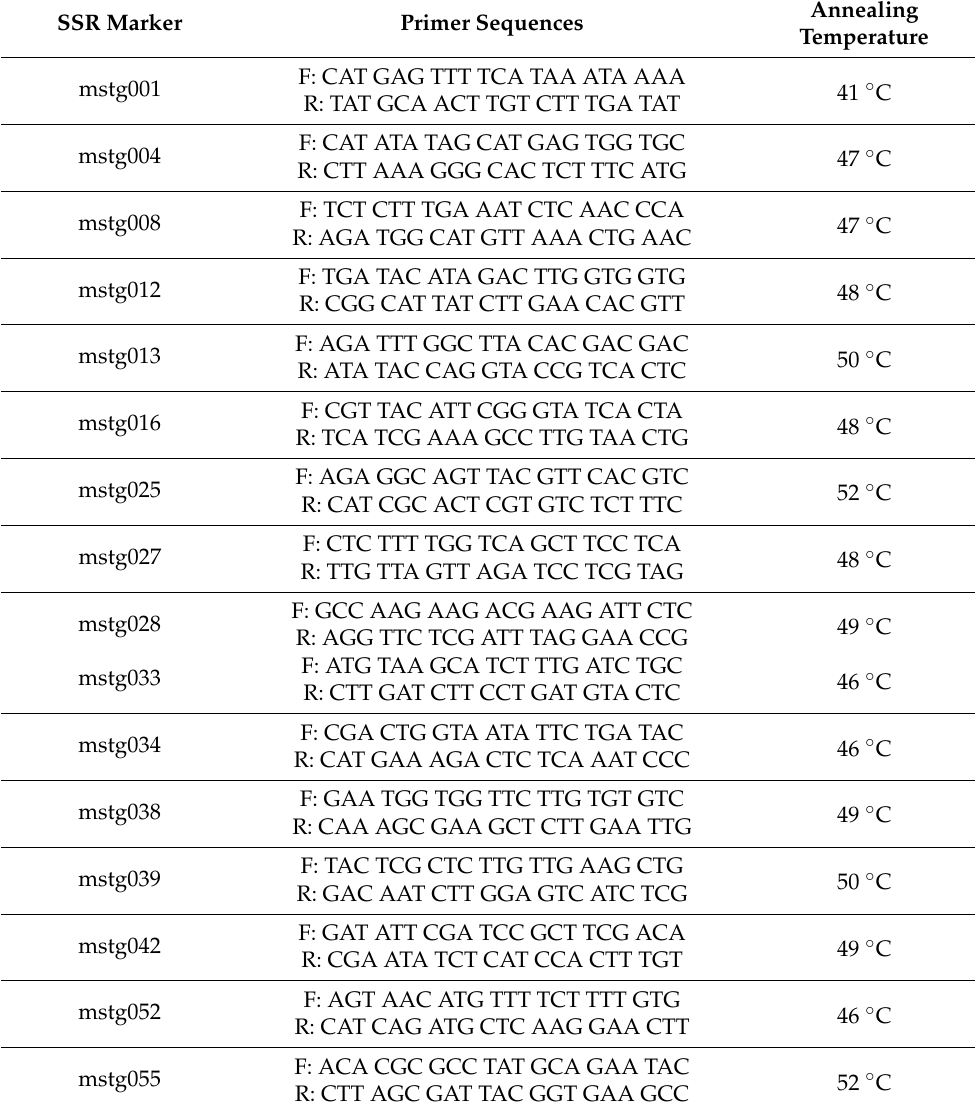
Table 2. Primer sequences and annealing temperatures of SSR markers used in the study. SSR Marker Primer